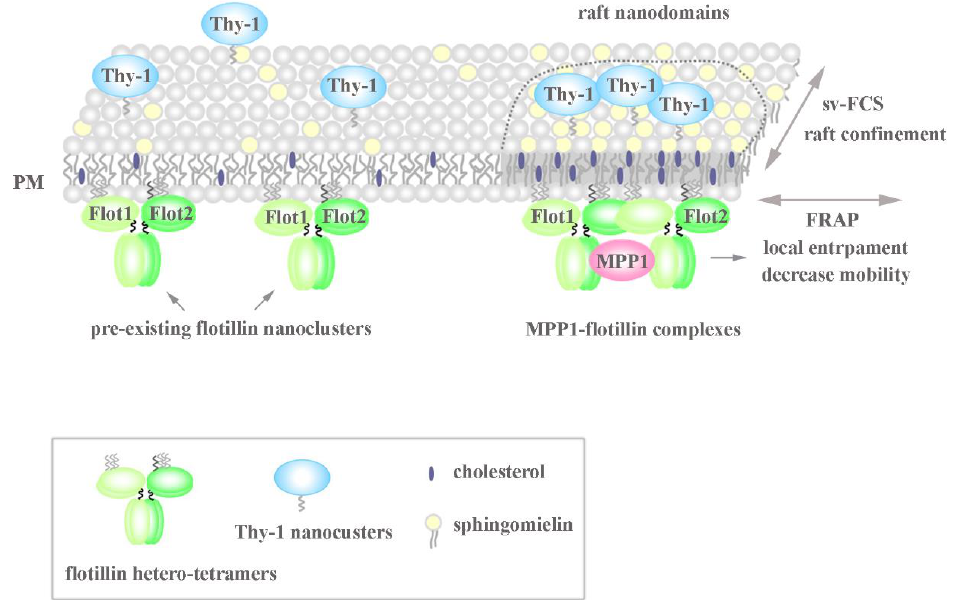
Figure 5. Model of the MPP1-flotillin dependent organization of raft nanodomains. MPP1 acts as a raft-sequestering molecule and organizes raft nanodomains due to mutual interactions with flotillins. The high-affinity binding of MPP1 to the pre-existing flotillin nanoclusters enhances their oligomerization and limits their lateral mobility in the PM, although the exact stoichiometry is not known. Such temporal immobilization triggers changes in the surrounding environment resulting in locally elicited concentration and confinement of other raft-associated molecules such as sphingomyelin and Thy-1. This rearmament drives the physicochemical changes in the PM, resembling the organization of more ordered domains reflecting functional raft nanodomains (for more details, see the text). MPP1-flotillin complexes act therefore as basic structural units organizing functional raft nanodomains.